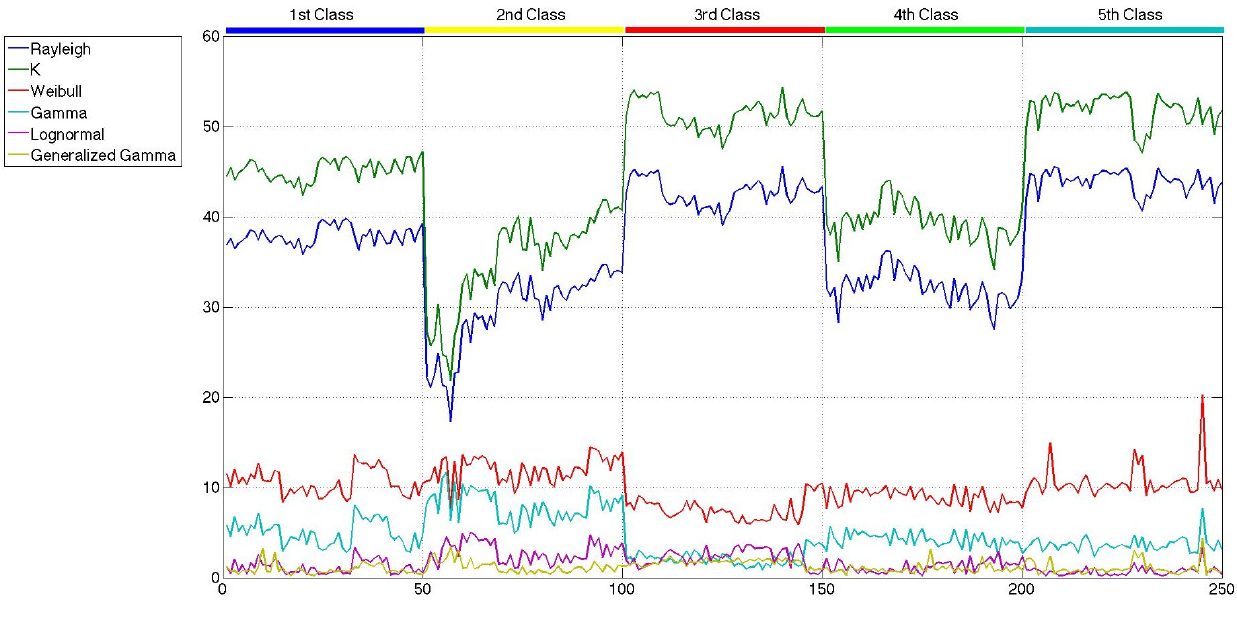
Figure 9. Cramér–von Mises distances measured for a reduced set of representative sigma-filtered patches.